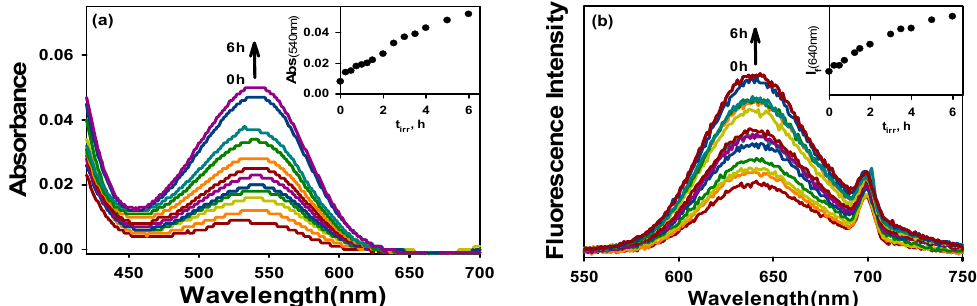
Figure 3. ( a ) Absorption and ( b ) fluorescence spectral changes of SP-IQ over time (0–6 h, Different color lines represent different times.) during the dark incubation. Inset: Plots of ( a ) absorbance at 540 nm and ( b ) fluorescence intensity at 640 nm vs . irradiation time.